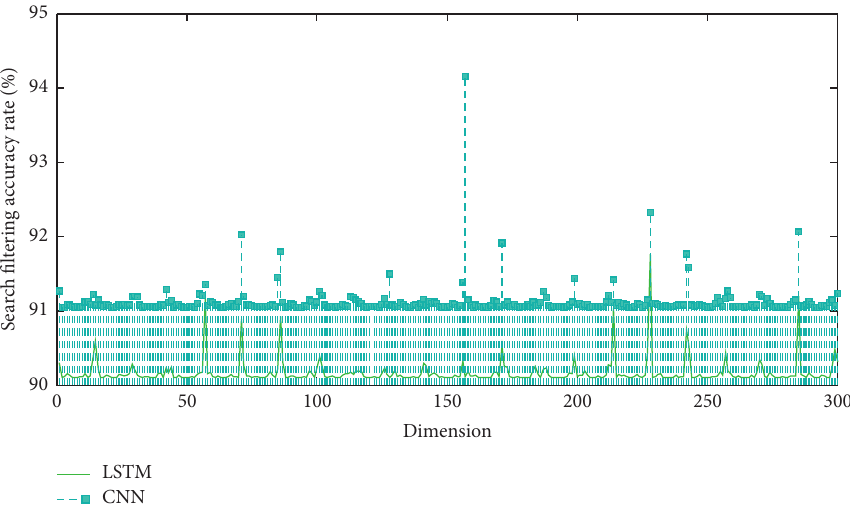
Figure 10: The accuracy of search filtering at the positioning